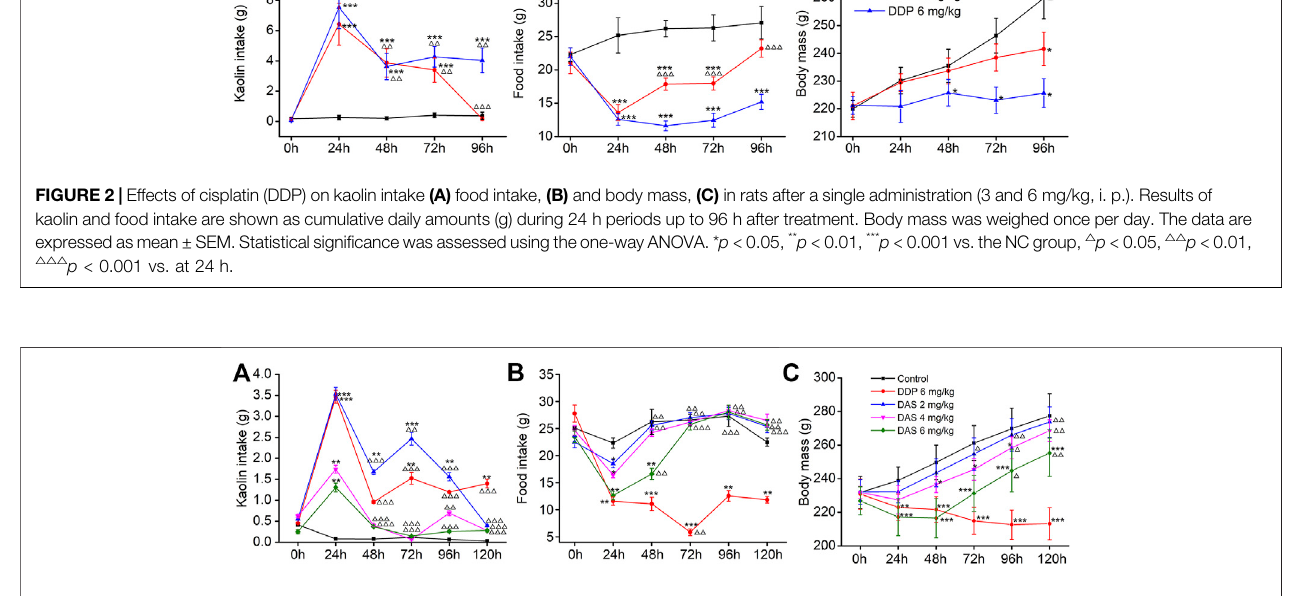
FIGURE3| Effectsofdichroaalkalisalt(DAS)onkaolinintake (A) foodintake, (B) andbodymass, (C) inratsafterasingleadministration.Control:saline,p.o.;DDP: 6 mg/kg,i.p.;DAS:2,4,and6 mg/kg,p.o.Resultsofkaolinandfoodintakeareshownascumulativedailyamounts(g)during24 hperiodsupto120 haftertreatment. Bodymasswasweighed onceper day.The dataareexpressed asmean ± SEM. Statistical signi fi cance wasassessed using theone-way ANOVA. * p < 0.05, ** p < 0.01, *** p < 0.001 vs. the NC group, △ p < 0.05, △△ p < 0.01, △△△ p < 0.001 vs. at 24 h.